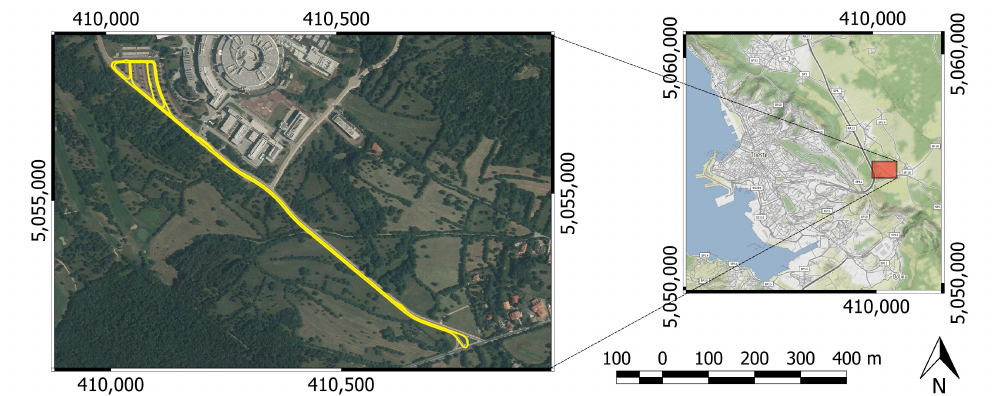
Figure 1. Surveyed Area. In yellow, the reference trajectory produced by the Mobile Mapping System Position and Orientation System for Land Vehicles (MMS POS/LV—Mobile Mapping System, Position and Orientation Systems for Land Vehicles) system. Reference system: RDN ETRS89-ETRF2000.